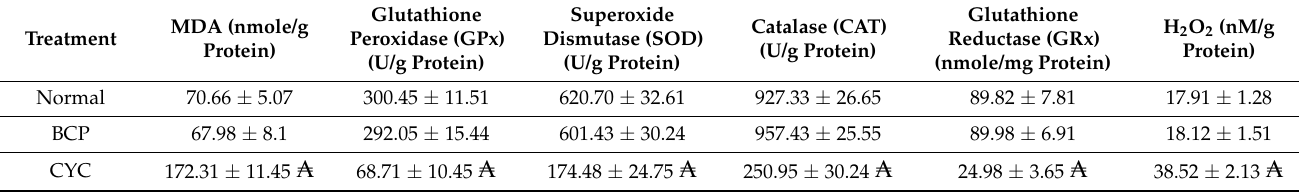
Table 4. Effects of treatment with β -caryophyllene (BCP) for 14 days on cyclophosphamide (CYC) Table 1. Effects of treatment with β -caryophyllene (BCP) for 14 days on cyclophosphamide (CYC) Table 1. Effects of treatment with β -caryophyllene (BCP) for 14 days on cyclophosphamide (CYC) Table 1. Effects of treatment with β -caryophyllene (BCP) for 14 days on cyclophosphamide (CYC) Table 1. Effects of treatment with β -caryophyllene (BCP) for 14 days on cyclophosphamide (CYC) Table 1. Effects of treatment with β -caryophyllene (BCP) for 14 days on cyclophosphamide (CYC) induced augmentation in oxidative stress and lipid peroxidation. Table 1. Effects of treatment with β -caryophyllene (BCP) for 14 days on cyclophosphamide (CYC) induced fluctuations in body and heart weights and heart to body weights ratio in rat. induced fluctuations in body and heart weights and heart to body weights ratio in rat. induced fluctuations in body and heart weights and heart to body weights ratio in rat. induced fluctuations in body and heart weights and heart to body weights ratio in rat. induced fluctuations in body and heart weights and heart to body weights ratio in rat. induced fluctuations in body and heart weights and heart to body weights ratio in Table 2. Effects of treatment with β -caryophyllene (BCP) for 14 days on cyclophosphamide (CYC) Table 2. Effects of treatment with β -caryophyllene (BCP) for 14 days on cyclophosphamide (CYC) induced fluctuations in ECG and heart rate. induced fluctuations in ECG and heart rate.